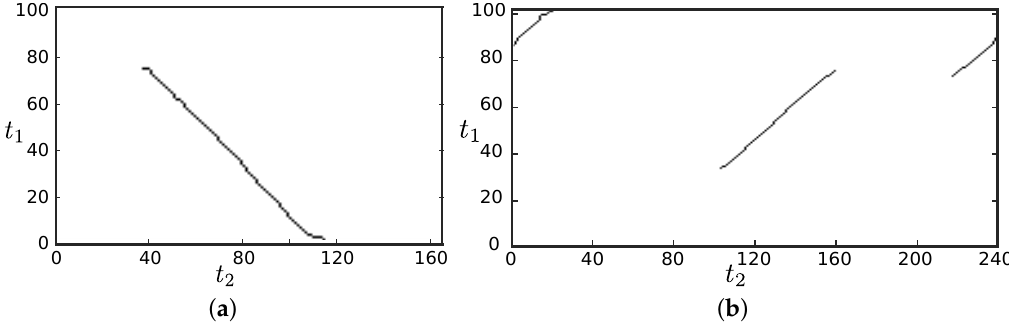
Figure 6. Examples of “sub-paths”. ( a ) example 2; ( b ) example 3.